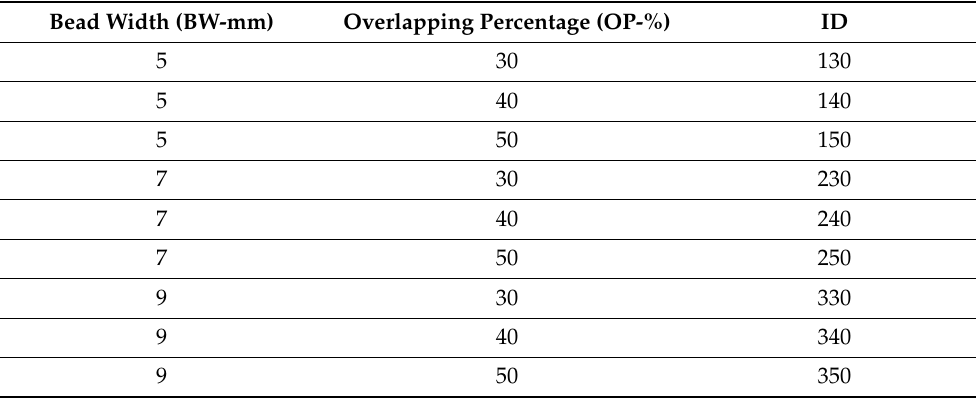
Table 3. Built blocks’ designation.